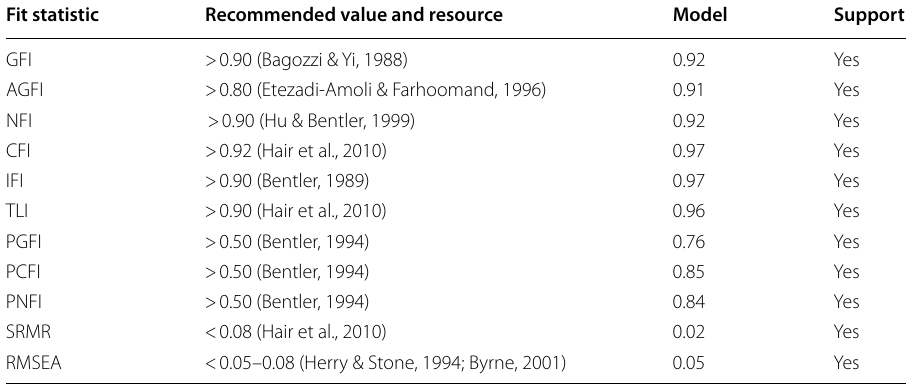
Table 5 Fit indices for the measurement model and structural model